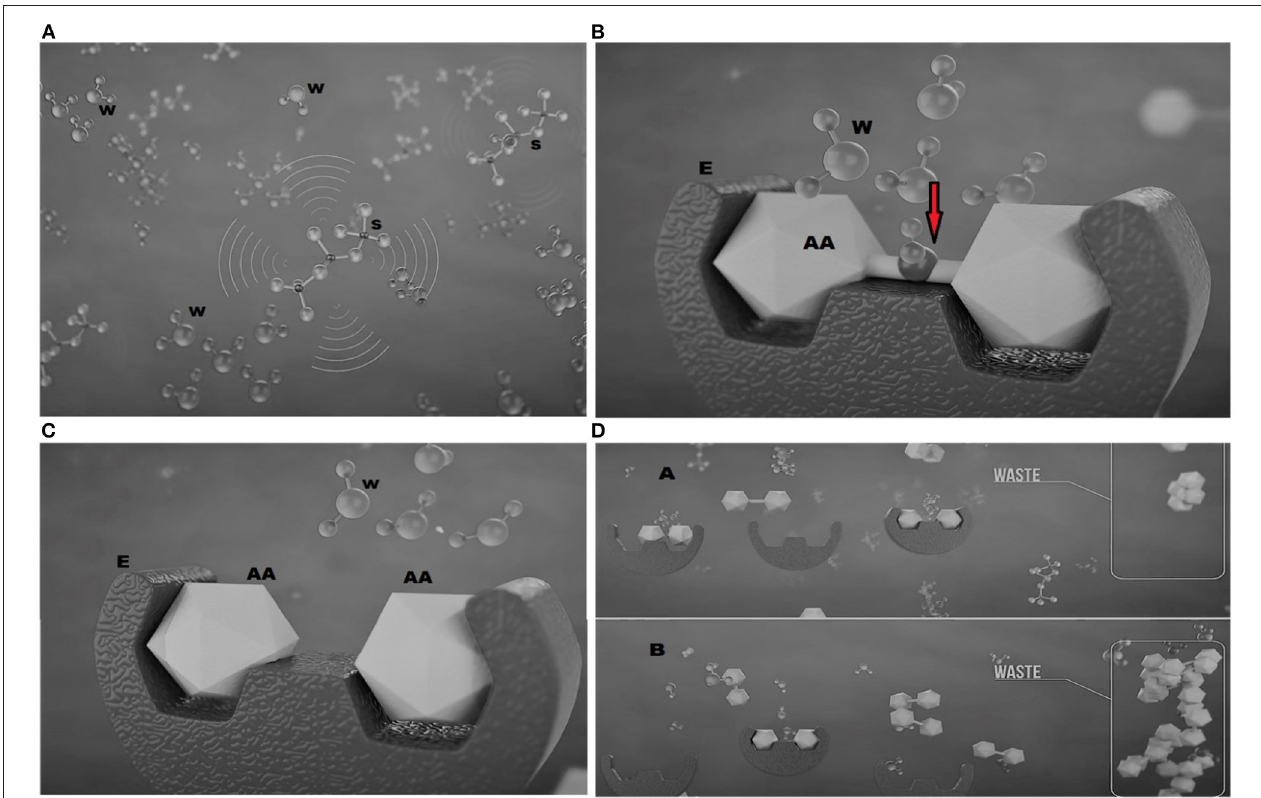
FIGURE 2 | Mechanisms of silica nanoparticles (NPs) responsible for the increased digestibility in tilapia fish (source: Ceresco Nutrition Ltd.) showing (A) silica NP(S) activating water molecules (W) inside the gut of fish; (B) activated water molecules (W) splitting (red arrow) the amino acid (AA) when it binds to a specific enzyme (E); (C) cleaved amino acids (AAs) suitable for absorption through the gut; and (D) the reduction in waste in the presence of silica NP (A) compared to that without (B) .